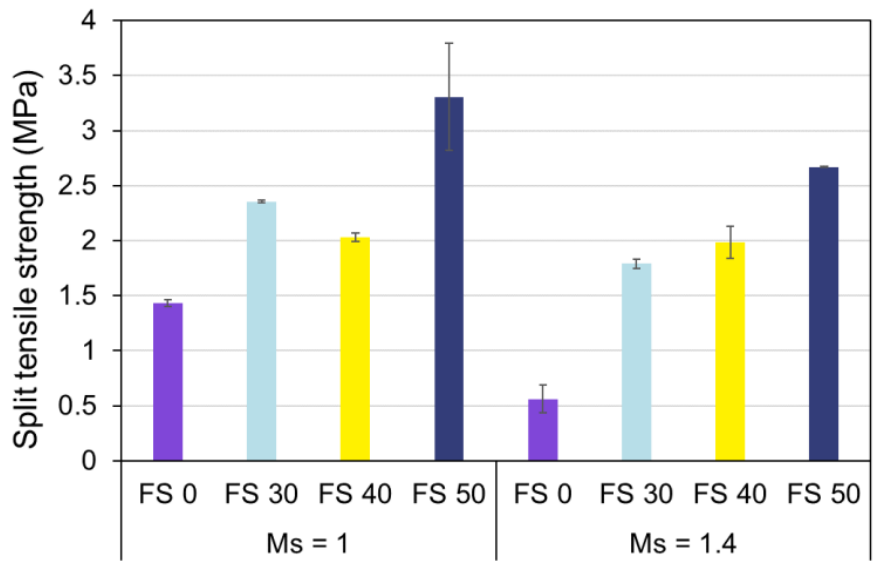
Figure 27. Split tensile strength of AAC.